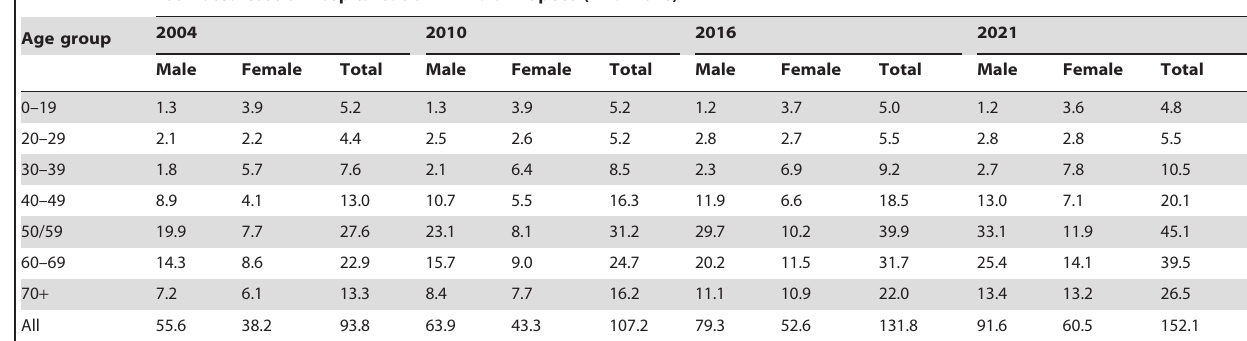
Estimated cost of hospitalisation in Indian rupees (in billions)